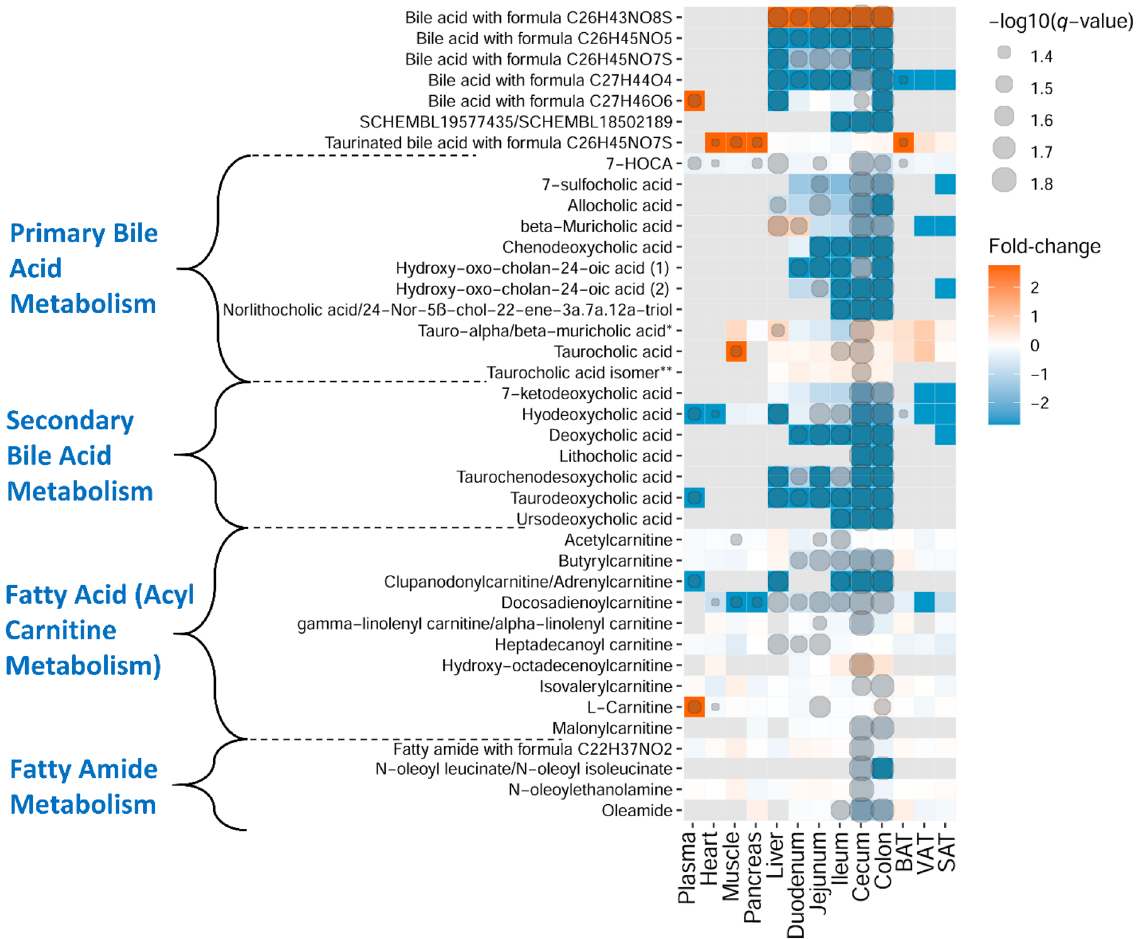
Figure 7. Heatmap representation of identified metabolites in bile acids, fatty amides, carnitine, and acylcarnitine metabolism classes. Fold-change (GF vs. MPF) and degree of significance comparisons were performed between the GF and MPF within each tissue (Mann–Whitney U-test and Benjamini and Hochberg false discovery rate correction p value ≤ 0.05, and q value ≤ 0.05). Each comparison for a tissue is represented by a colored cell. Gray cells represent metabolites that were not found in the tissue. Orange and blue cells represent metabolites more abundant in GF and MPF mice, respectively. *Despite comparing the spectra against the purified standard, we were not able to differentiate between tauro-α-muricholic acid and tauro-β-muricholic acid. **Taurocholic acid isomer: either taurallocholate or tauroursocholate or